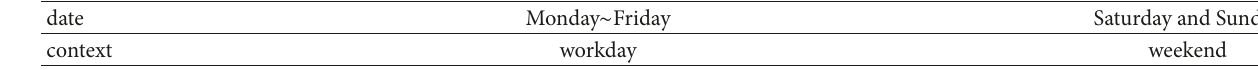
Table 1: The Division of Time (date).